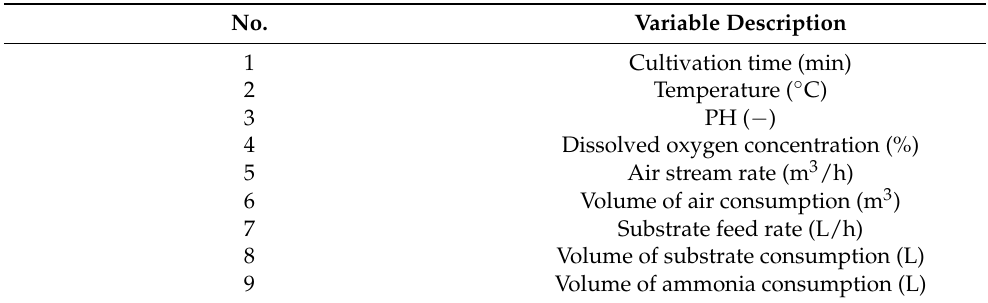
Table 6. Input variables of soft sensor models for industrial fed-batch CTC fermentation